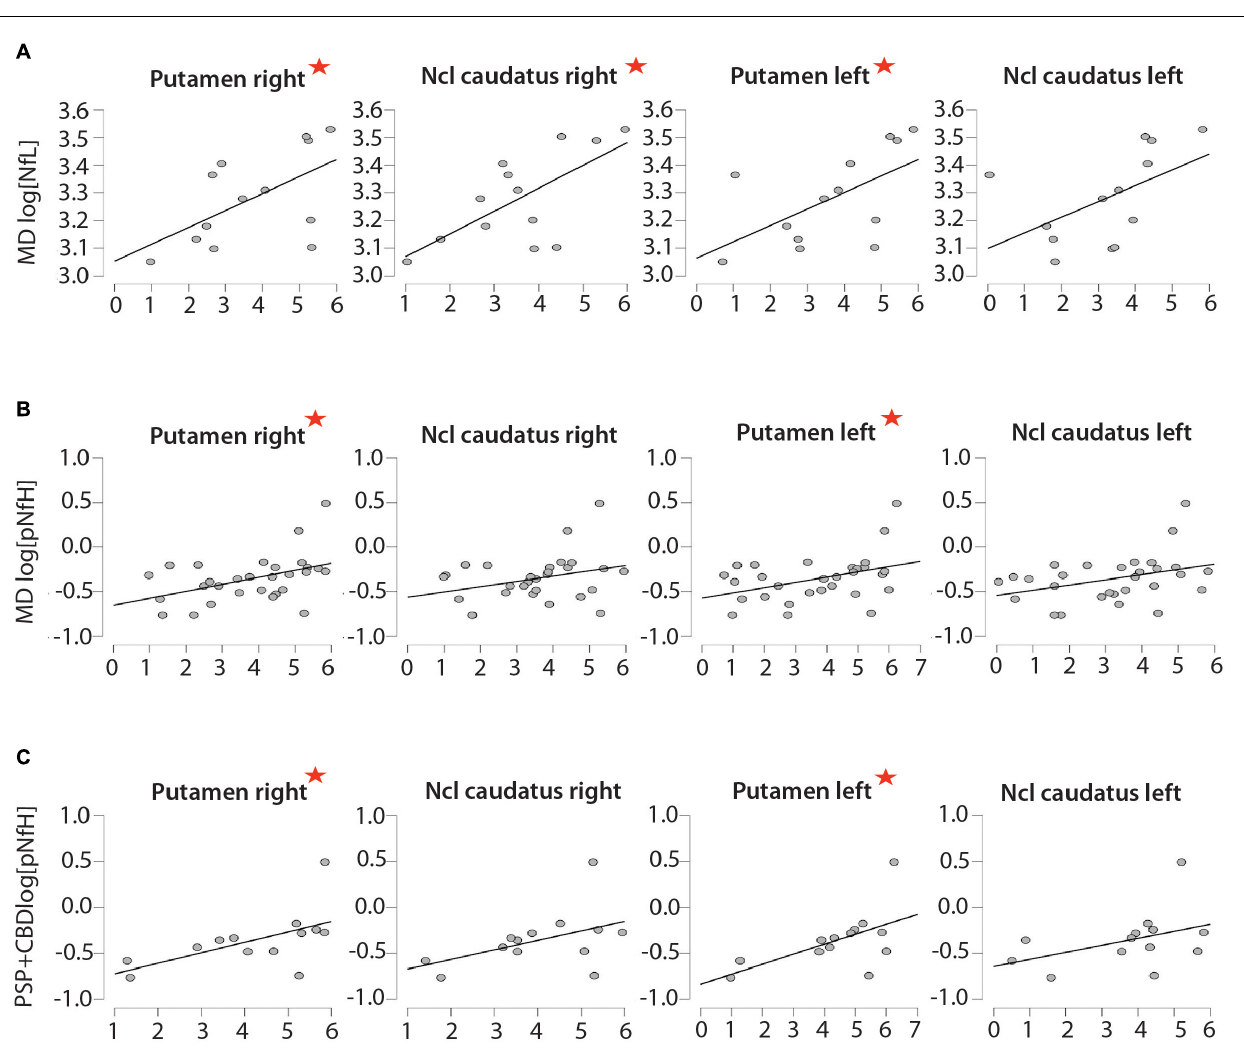
The mean age of all subcohorts did not differ